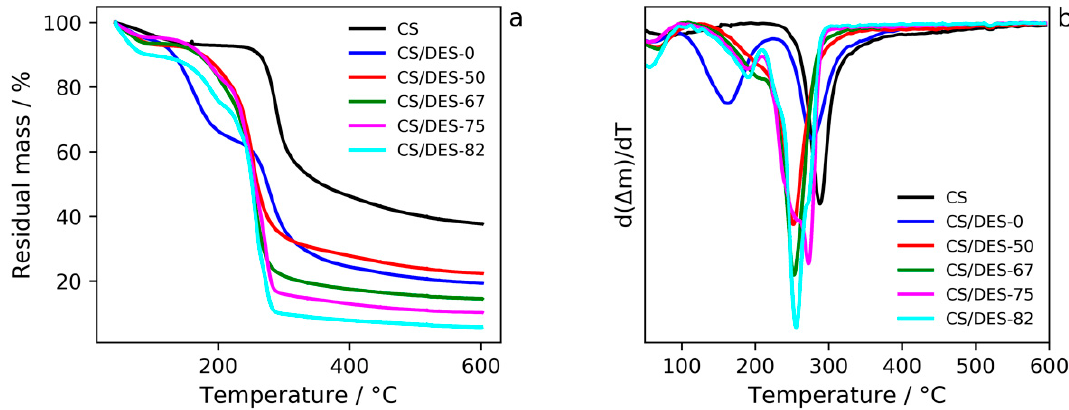
Figure 7. TGA ( a ) and DTG ( b ) curves for CS, CS-LA film (CS/DES-0) and films with different NADES contents (50, 67, 75 and 82 wt%).